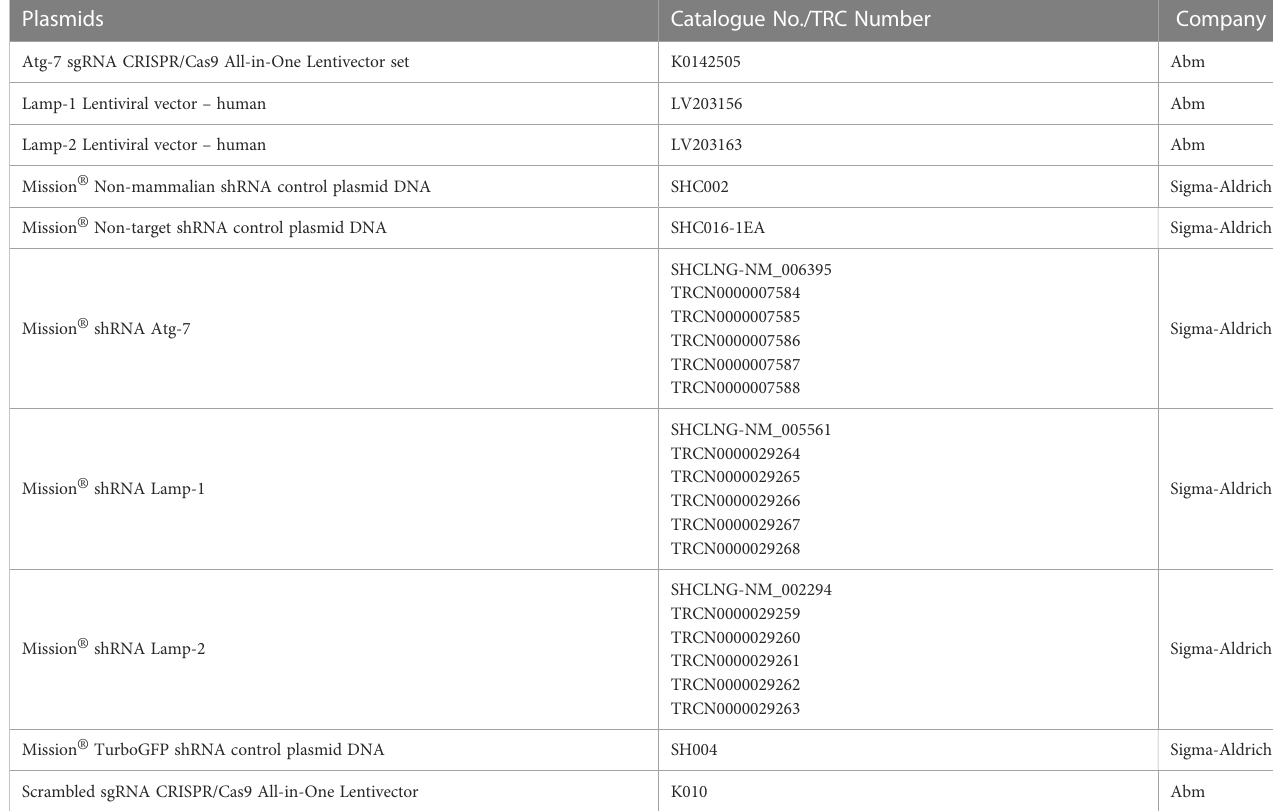
TABLE 2 Sequences of shRNA and CRISPR plasmids. Plasmids